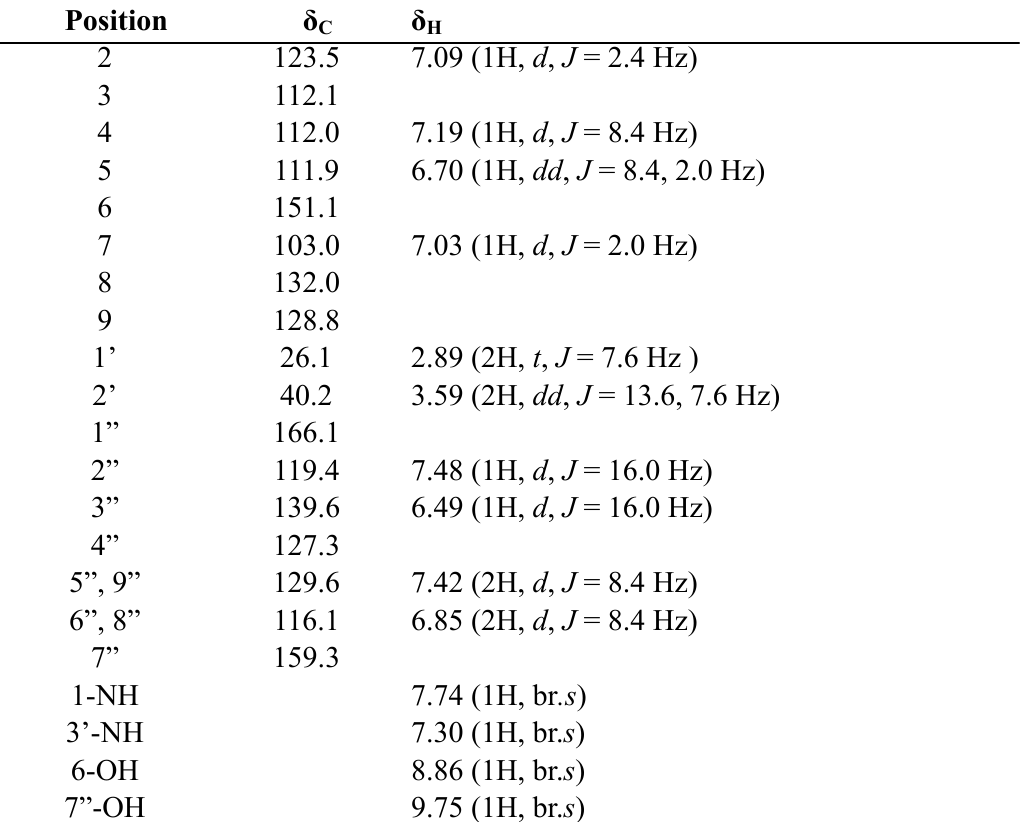
Table 2. 1 H- and 13 C-NMR data for compound 2 (400 and 100 MHz in acetone- d